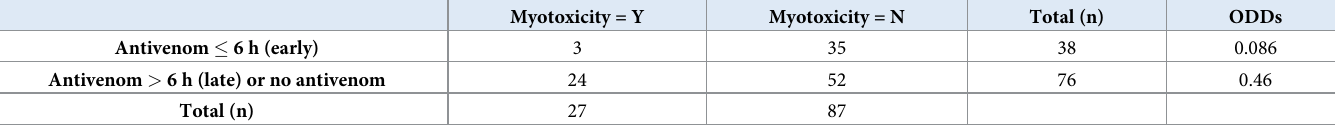
Table 2. Odds of myotoxicity following red-bellied black snake envenomation in patients that received early antivenom and late/no antivenom treatment. Myotoxicity =